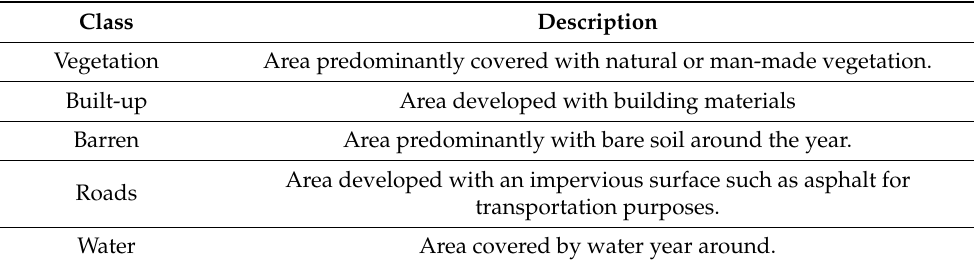
Table 2. LULC Classification